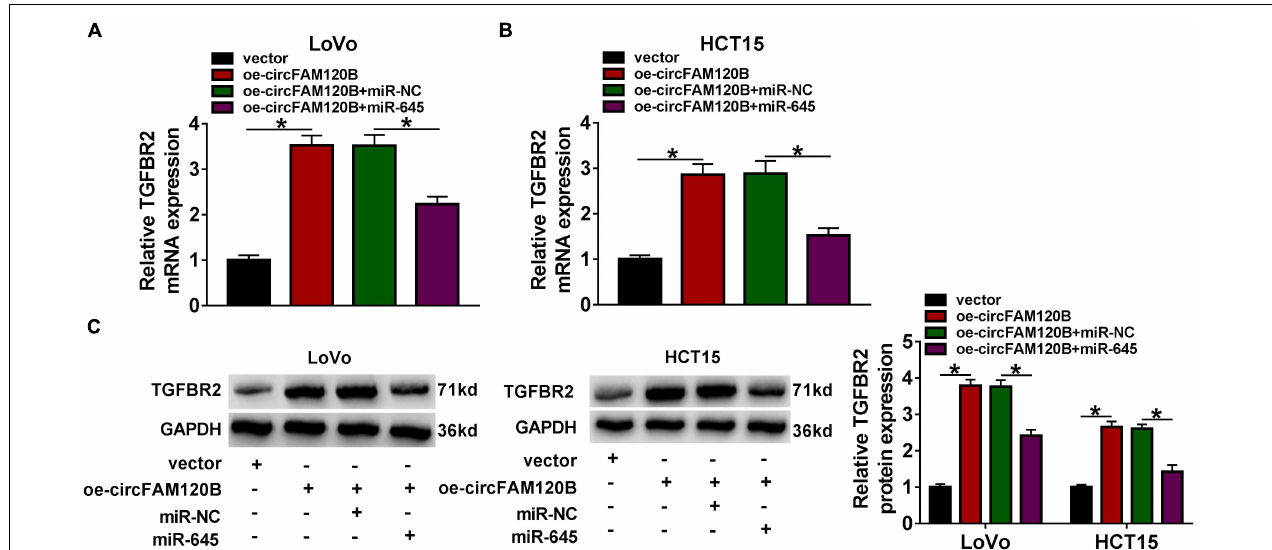
FIGURE 7 | CircFAM120B activated the expression of TGFBR2 by targeting miR-645. In LoVo and HCT15 cells transfected with oe-circFAM120B, vector, oe-circFAM120B + miR-645 or oe-circFAM120B + miR-NC, the expression of TGFBR2 was detected by (A,B) qRT-PCR and (C) western blot. * P < 0.05.